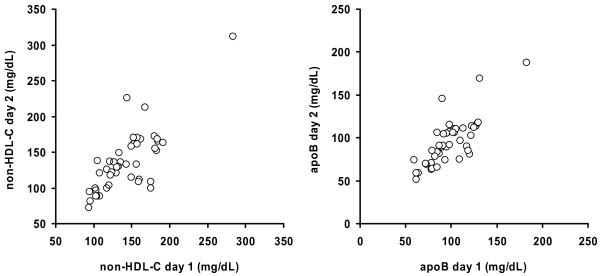
Plots of untransformed values obtained on day 1 (X axis) and day 2 (Y axis) for non-HDL-cholesterol (non-HDL-C; left panel) and apolipoprotein B100 (ApoB; right panel) ratios in n = 45 subjects with diabetes mellitus.